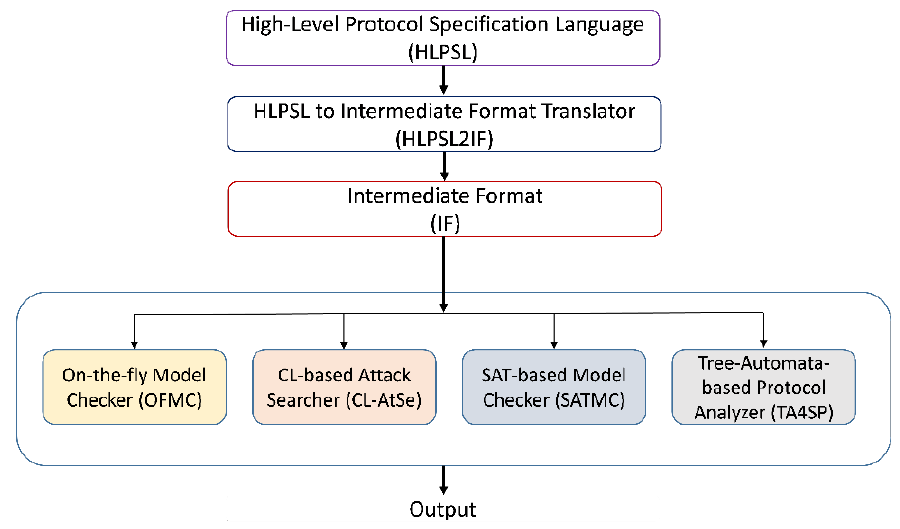
Figure 3. AVISPA system structure.